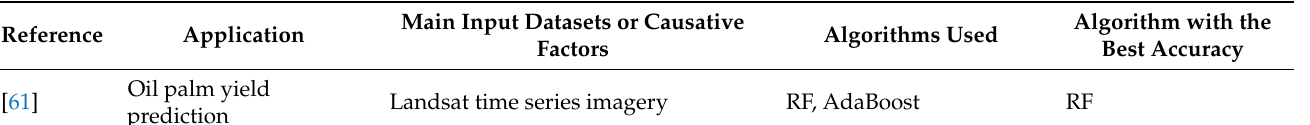
Table 2. Summary of reviewed applications that used ensemble learning